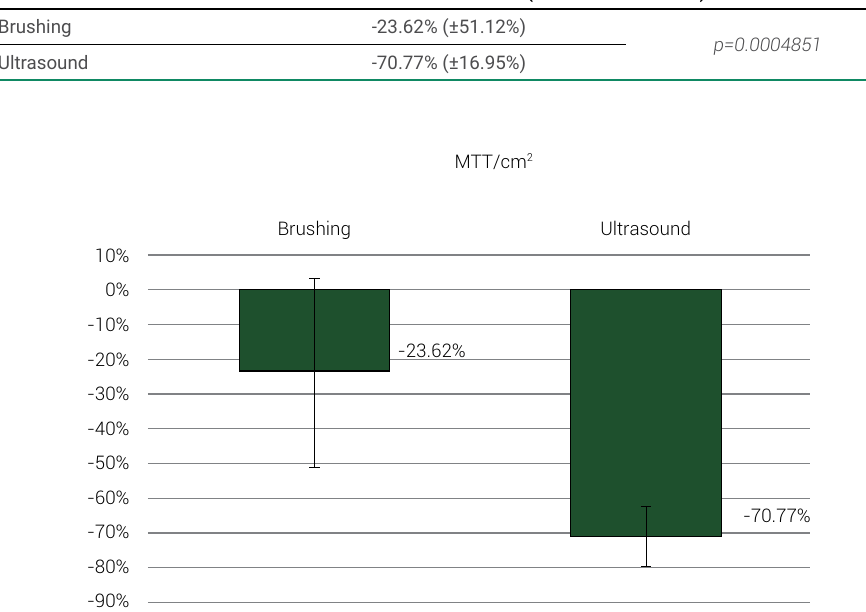
Figure 2. Means and 95% confidence intervals of percentage change of biofilm